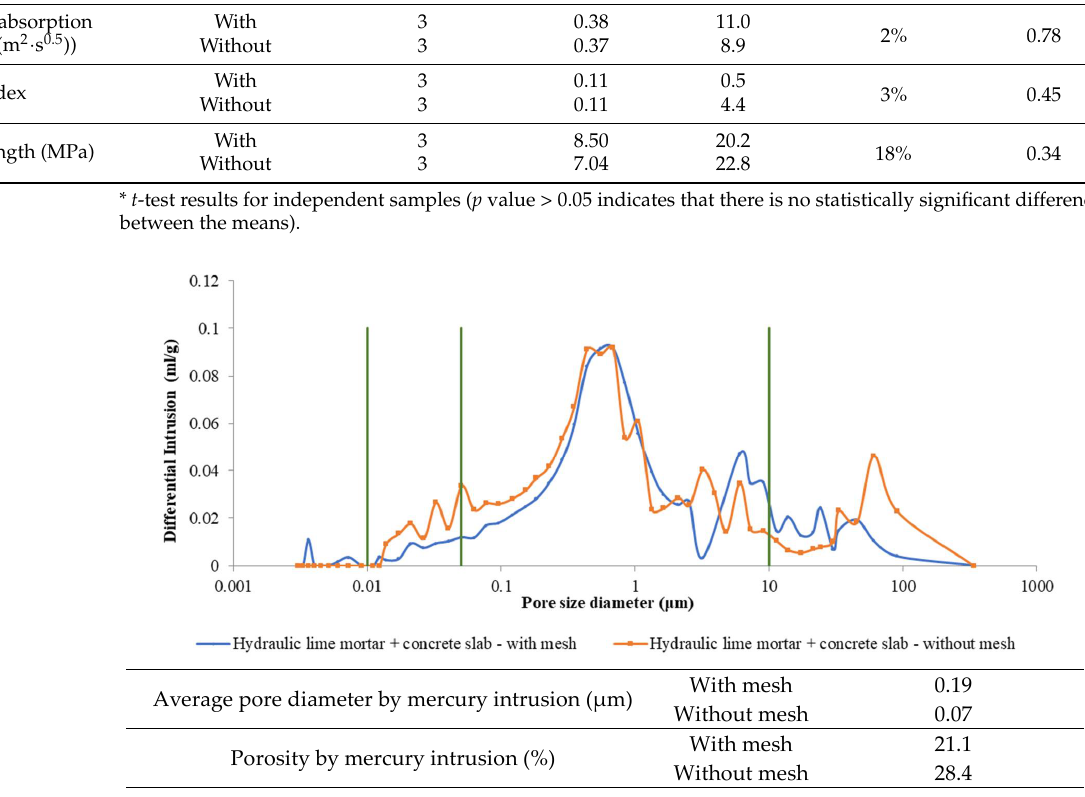
Figure 9. Porosimetry properties obtained by mercury intrusion of hydraulic lime mortar applied to concrete slab substrate, with and without mesh. Table 8. Hydraulic lime mortar applied to the lightweight concrete block substrate.